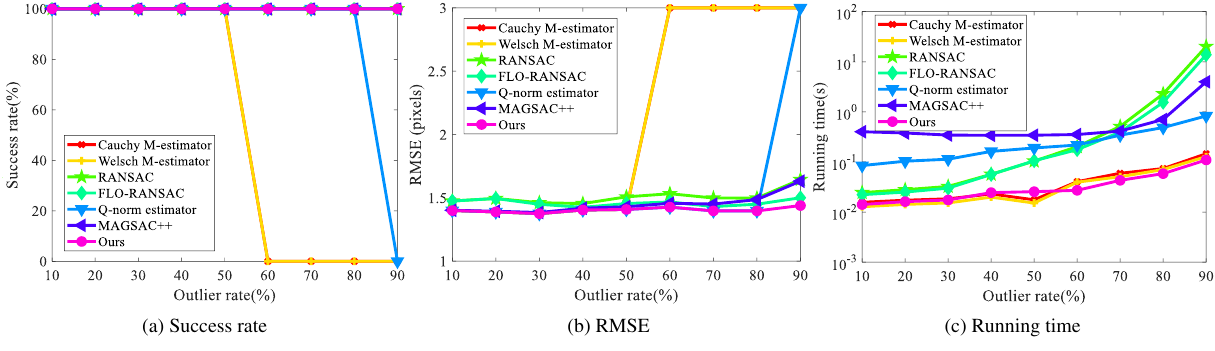
Figure 7. Comparison of image orientation results on the simulated data.